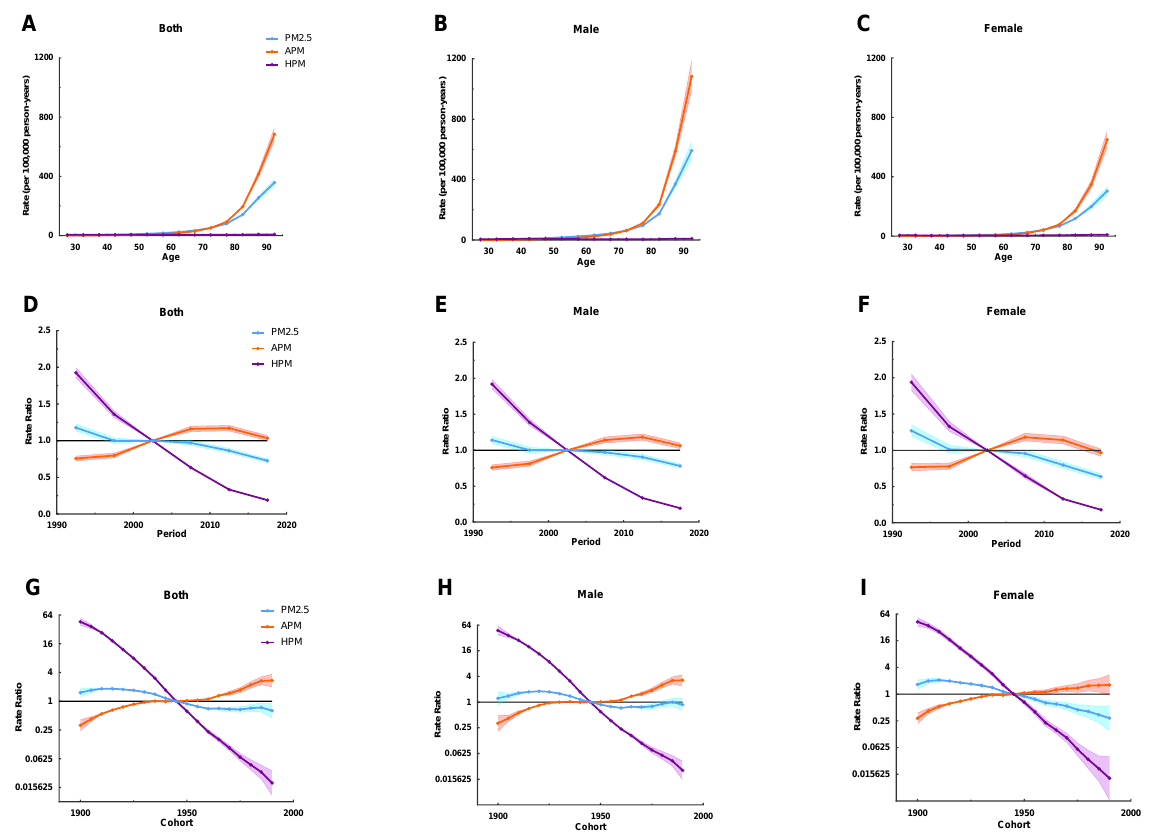
Figure 3. The age-period-cohort (APC) results of IHD attributable to PM 2.5 (APM and HPM) in Jiangsu from 1990 to 2019. ( A – C ) Fitted longitudinal age curves of IHD mortality (per 100,000) attributable to PM 2.5 (APM and HPM), with ( A ) corresponding to both sexes, ( B ) corresponding to males, ( C ) and corresponding to females. ( D – F ) Rate ratio of each period compared with the reference (2000–2004) adjusted for age and nonlinear cohort effects and the corresponding 95% CI, with ( D ) corresponding to both sexes, ( E ) corresponding to males, ( F ) and corresponding to females. ( G – I ) Rate ratio of each cohort compared with the reference (cohort 1943–1947) adjusted for age and nonlinear period effects and the corresponding 95% CI, with ( G ) corresponding to both sexes, ( H ) corresponding to males, ( I ) corresponding to females. The dots and shaded areas denote mortality rates or rate ratios and their corresponding 95%CI.